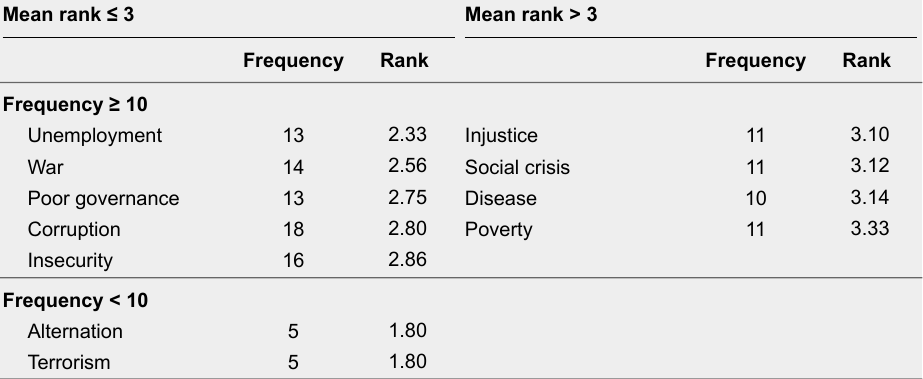
Structure of Risk Representation for Fang-Beti Participants According to Free-Association Analysis (EVOC)